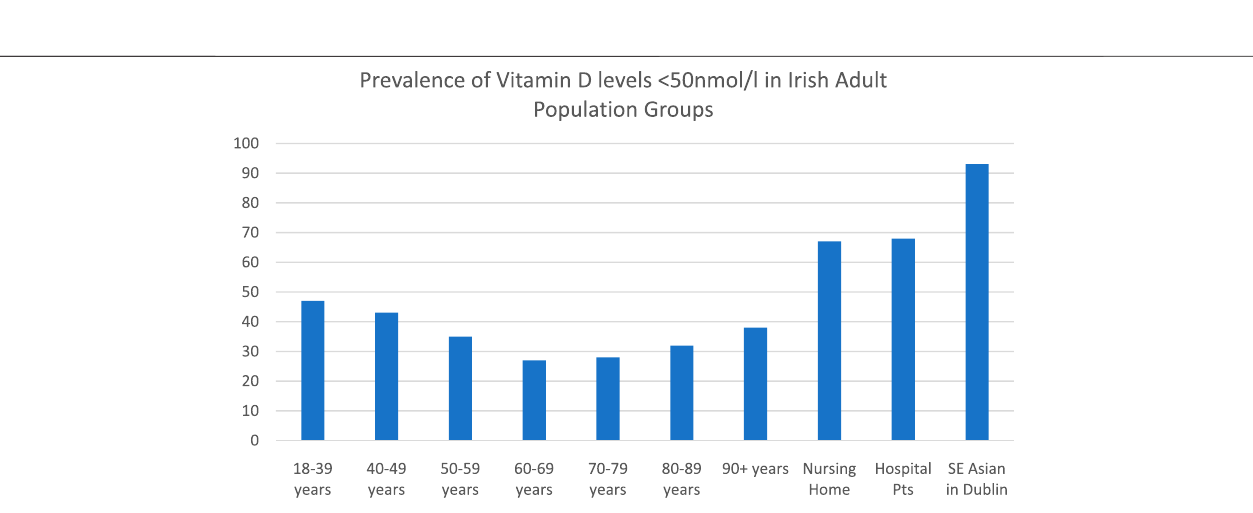
FIGURE 4 | Prevalence of Vitamin D levels < 50 nmol/L in Irish adult population groups. Adapted from Scully et al., 2020 (https://doi.org/10.3390/nu12092663); Grif fi n et al., 2020 (https://doi.org/10.1093/gerona/glaa010), Laird et al., 2020b (DOI: 10.3390/nu12123674).